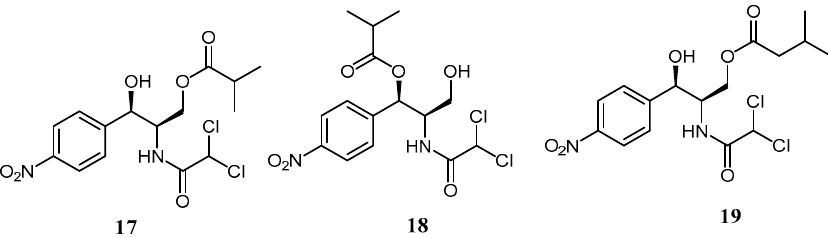
Figure 3. O -Acyl CAM derivatives identified from L. enzymogenes